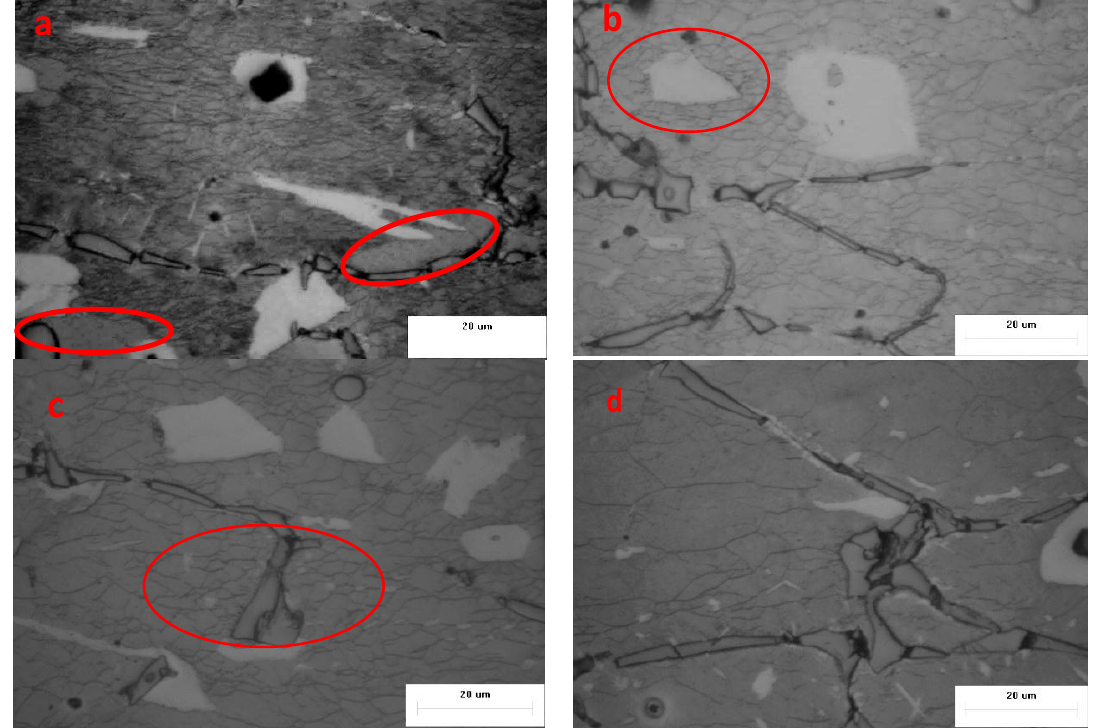
Figure 7. Optical microstructure of the material deformed at strain of 0.4 and ( a ) 150 ◦ C, 1 s − 1 ; ( b ) 200 ◦ C, 1 s − 1 ; ( c ) 250 ◦ C, 1 s − 1 ; ( d ) 300 ◦ C, 1 s − 1 .